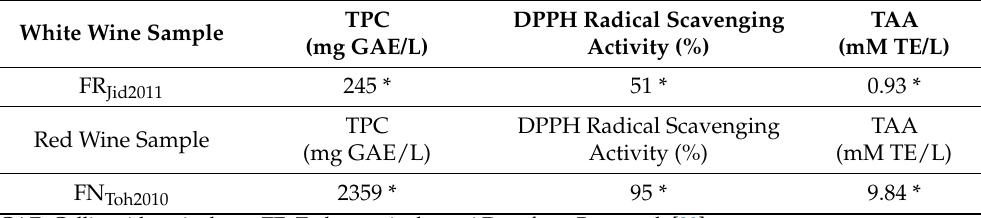
Table 1. Total phenolic content (TPC), DPPH radical scavenging activity (%) and total antioxidant activity (TAA) of the two wine samples used in this study (mean value ( n = 3)). White Wine